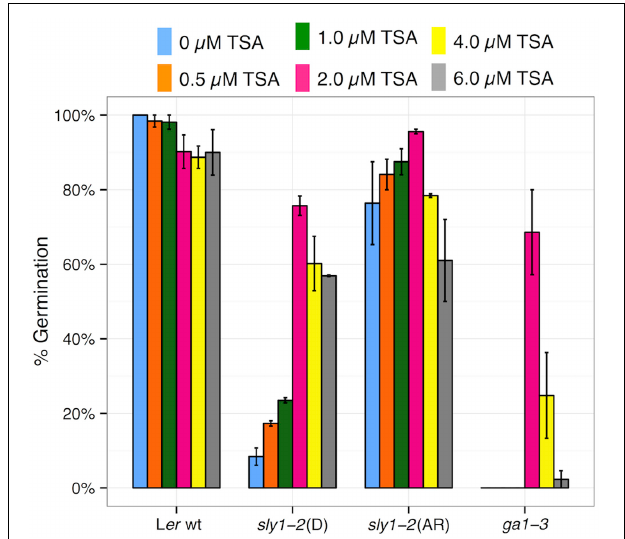
FIGURE 11 | Germination of L er wt, sly1-2 (D), sly1-2 (AR), and ga1-3 was conducted on varying concentrations of the histone deacetylase inhibitor, tricostatin A (TSA). TSA stimulated germination of both dormant sly1-2 and of ga1-3 . Rescue of germination was most efficient at 2.0 µ M